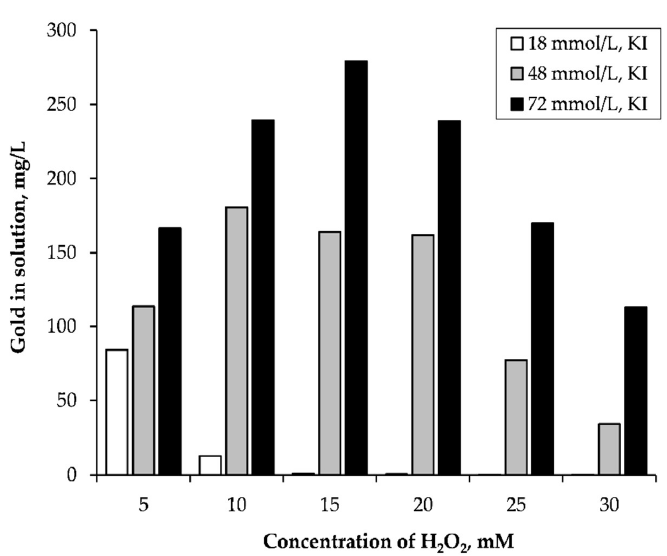
Figure 3. Gold extraction as functions of KI and H 2 O 2 concentrations in the KI–H 2 O 2 –H 2 SO 4